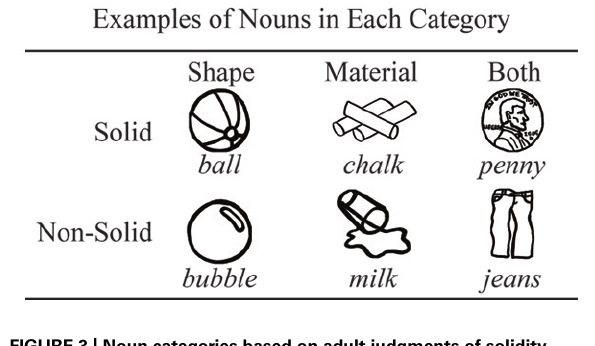
FIGURE 3 | Noun categories based on adult judgments of solidity (solid or non-solid) and characteristic feature (shape, material, or both) for nouns in the MCDI vocabulary checklist. Examples of words in the MCDI that fit into each of the six categories of interest are shown.